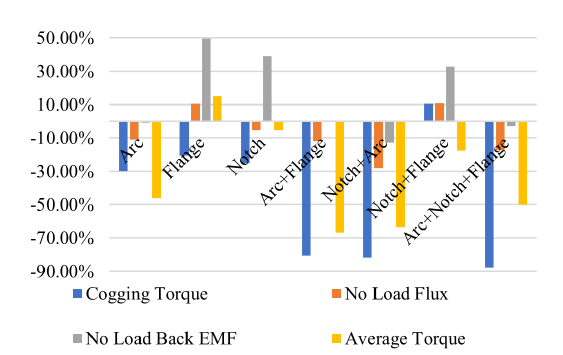
Figure 33. Comparison of cogging torque reduction